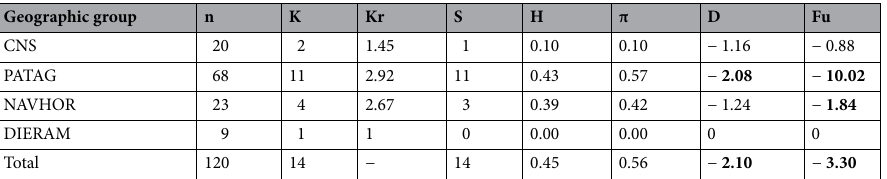
Table 1. Measures of genetic diversity based on mtDNA in different Aphrastura geographic groups. CNS Center, north and south, PATAG Patagonia (Chiloé to Tierra del Fuego), NAVHOR Navarino and Horn islands, DIERAM Diego Ramírez, N sample size, K number of haplotypes, Kr number of haplotypes based on rarefaction curves to compare diversity in geographic groups with different sample sizes (see “Methods” for details), S number of polymorphic sites, H heterozygosity, π average number of nucleotide differences between pairs of sequences, D Fu and Li’s D neutrality test, Fu Fu’s neutrality test. Statistically significant values are indicated in bold.